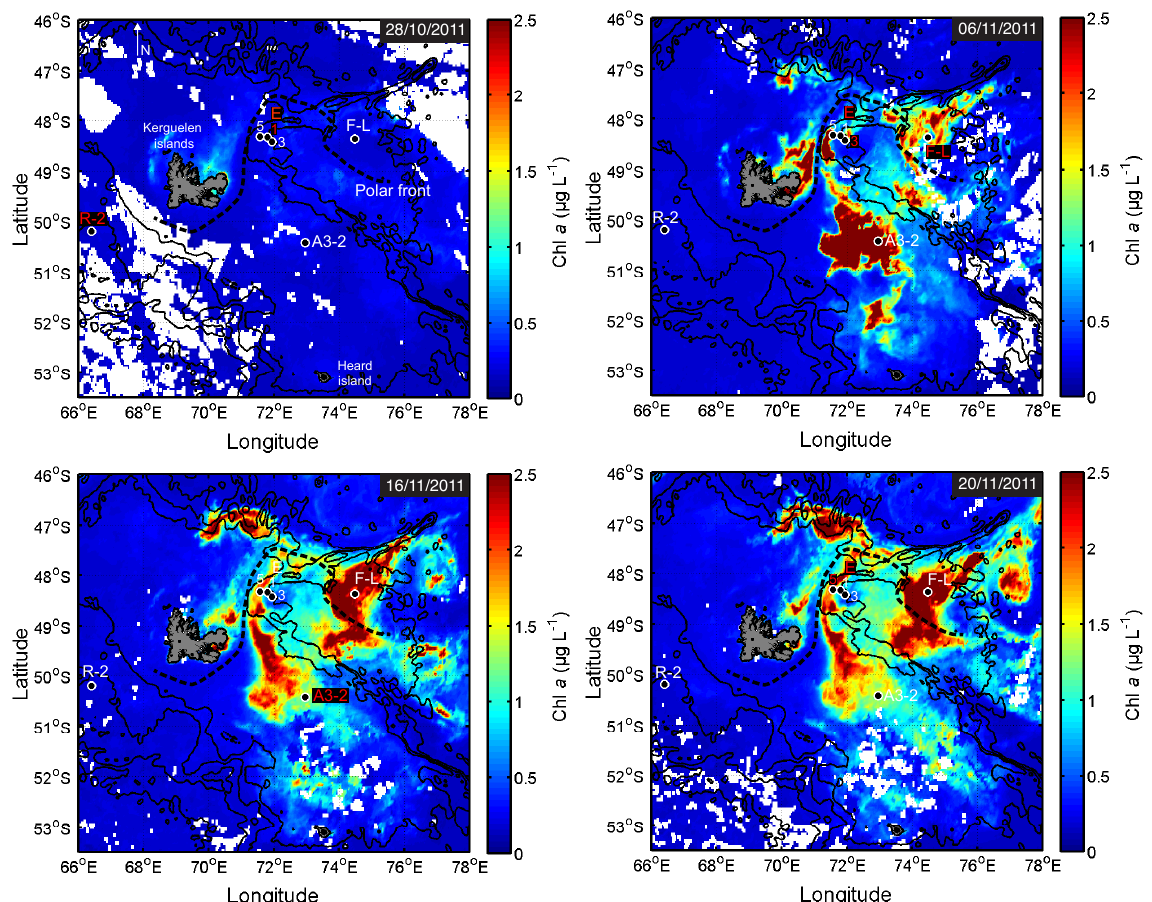
Figure 1. MODIS-Aqua satellite (CLS-CNES) images of surface chlorophyll a concentration (Chl a ) at different bloom stages from 28 Oc- tober to 20 November 2011. Images show free-drifting sediment trap deployment locations in contrasting biomass levels. On each map, red labels represent the station(s) sampled at the date of the map ± 3